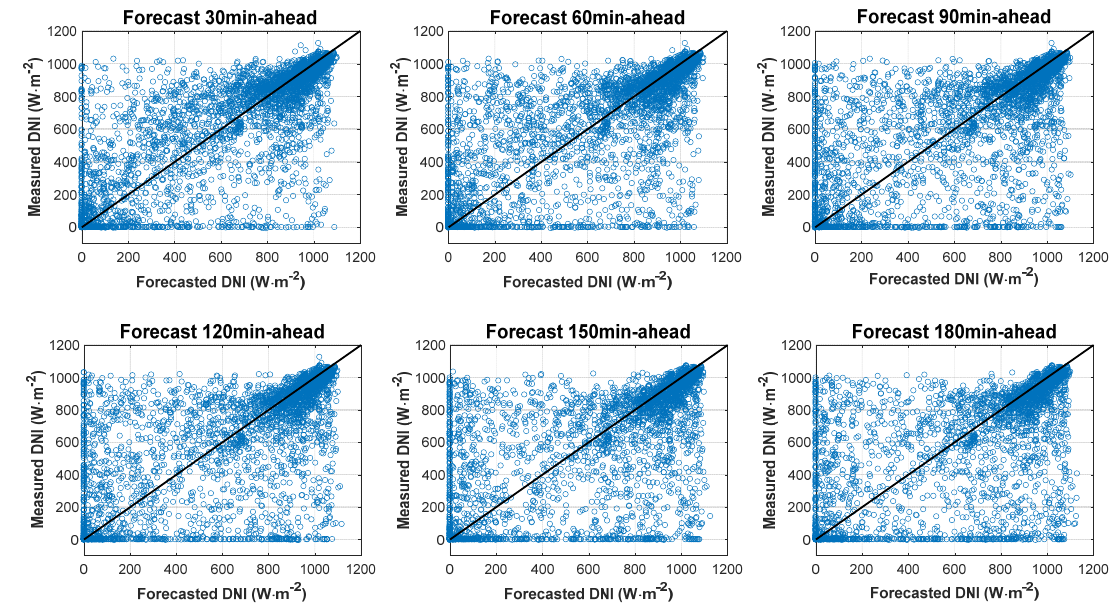
Figure 10. Forecasting DNI values by the model using FY-4A satellite observations versus ground measured values for the time horizon from 30 to 180 min.